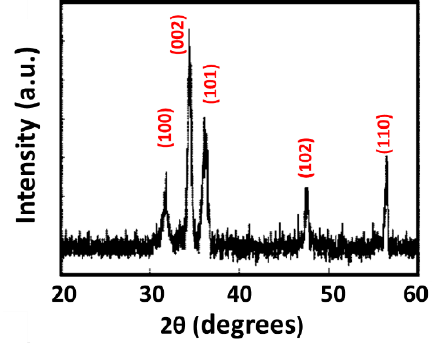
Figure 3. XRD patterns of ZnO detectors.